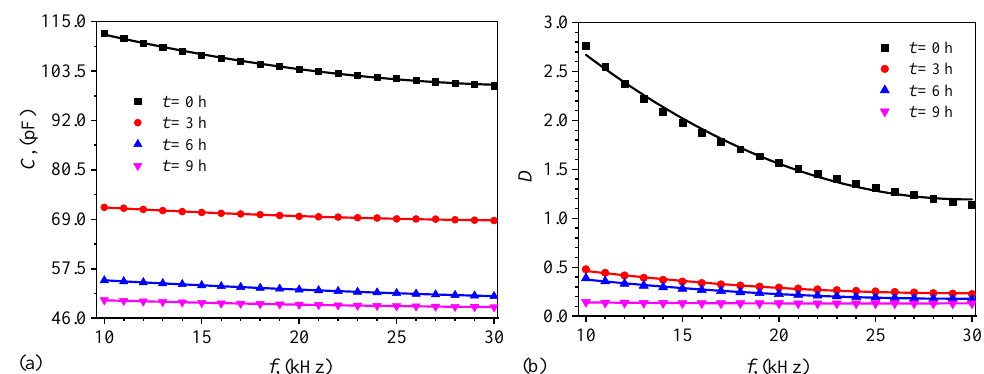
Figure 9. Variations in ( a ) capacitance C , and ( b ) dielectric loss tangent D of the electrical device containing only honey (i.e., ED 2 ), with the frequency f of a sinusoidal electric field at B = 0 mT and at various times t